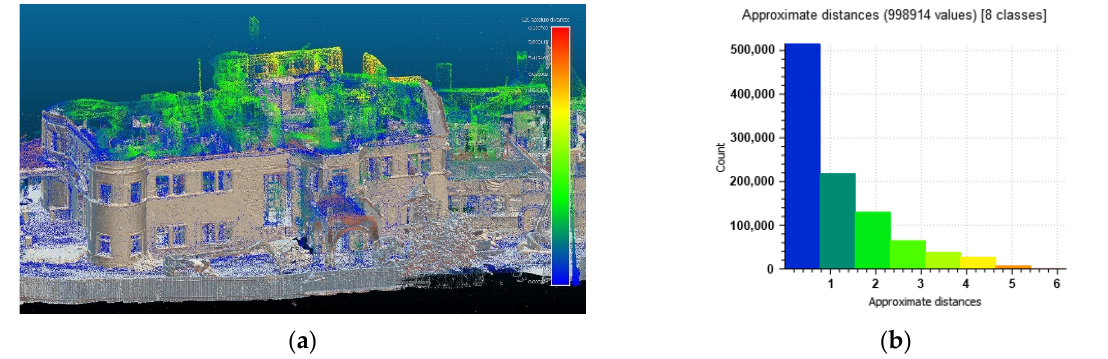
Figure 10. Denoised and filtered point cloud connected with terrestrial and aerial photogrammetry ( a ) and histogram of interconnection points ( b ).